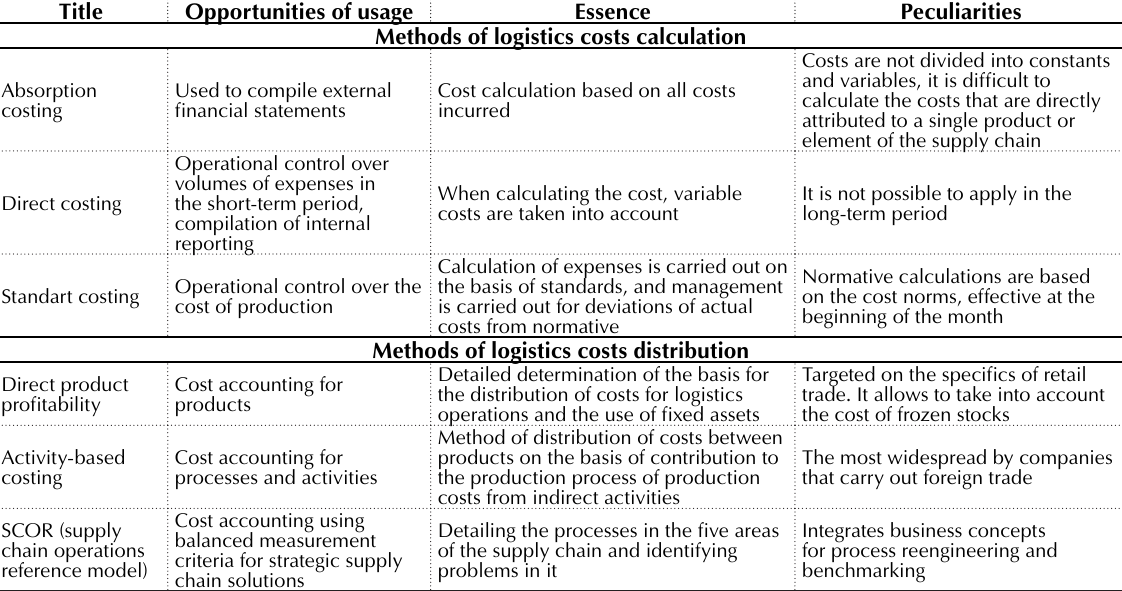
Table 2. Logistics costs accounting